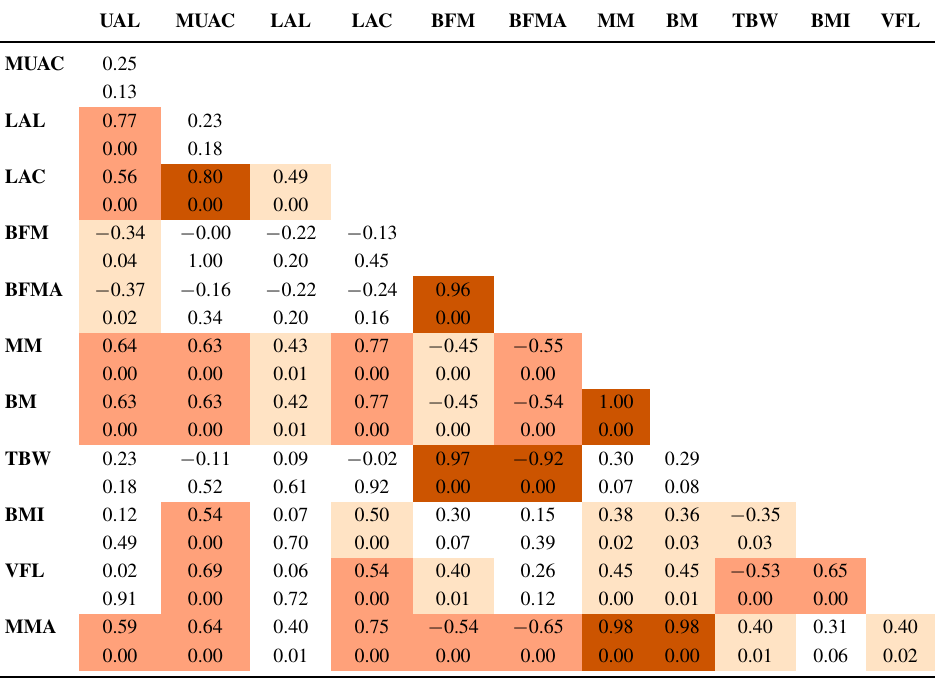
Table 2. Correlations between anthropometric and body composition variables: (cid:4) weak correlation; (cid:4) moderate correlation; (cid:4) strong